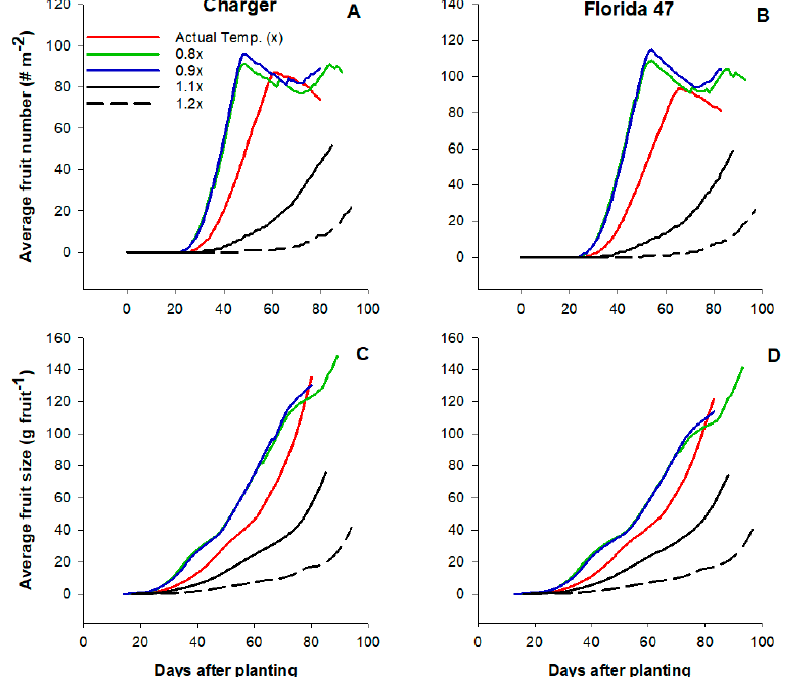
Figure 5. Effects of variations in air temperature on tomato fruit number ( A , B ) and fruit size ( C , D ) of two drip irrigated commercial fresh market tomato varieties (Charger and Florida 47) in Immokalee Florida.